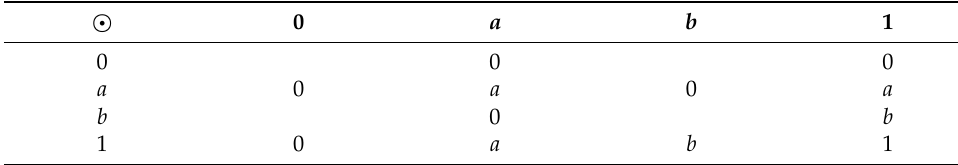
Table 1. The operation (cid:12) .